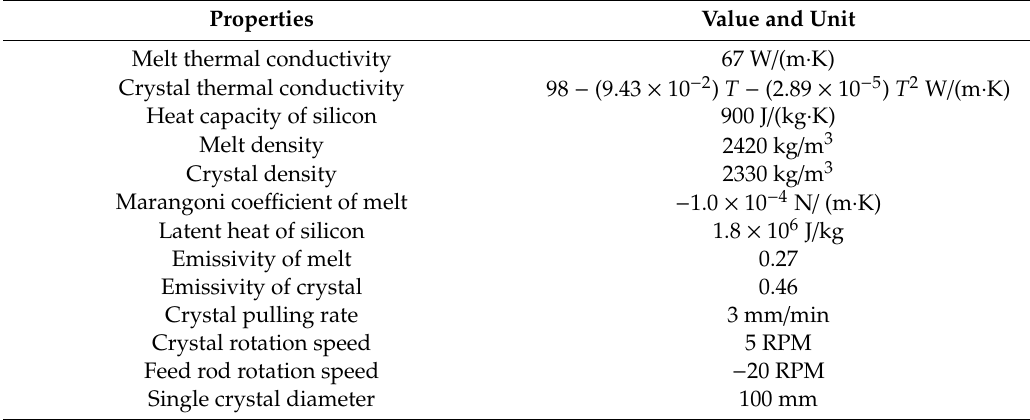
Table 2. Process parameters and physical